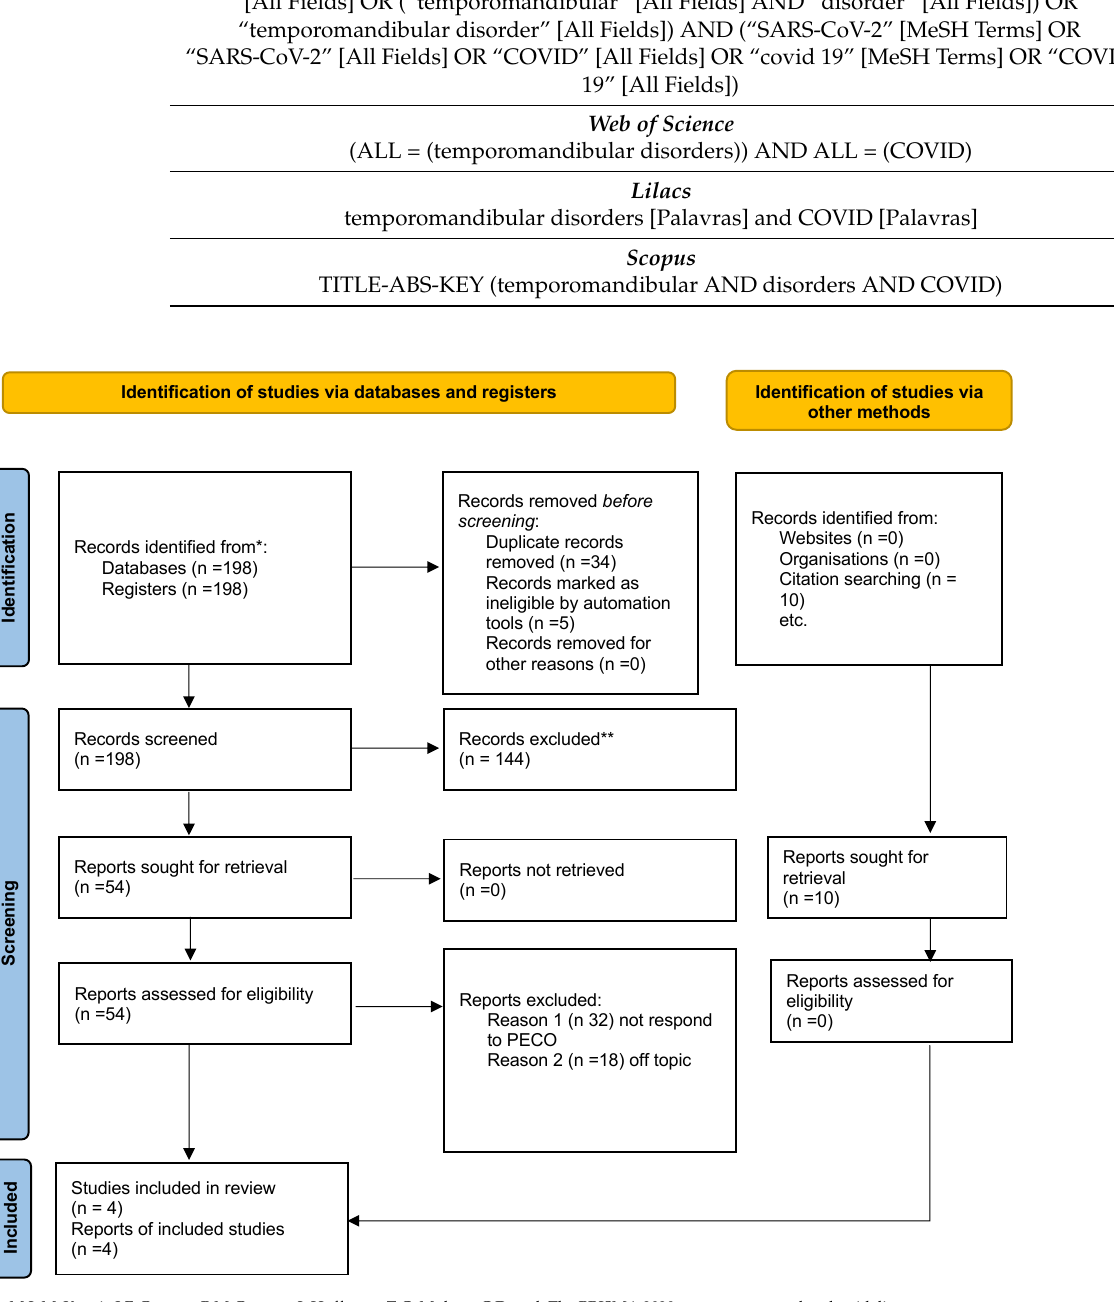
Figure 1. PRISMA flowchart [50]. * excluded because they are